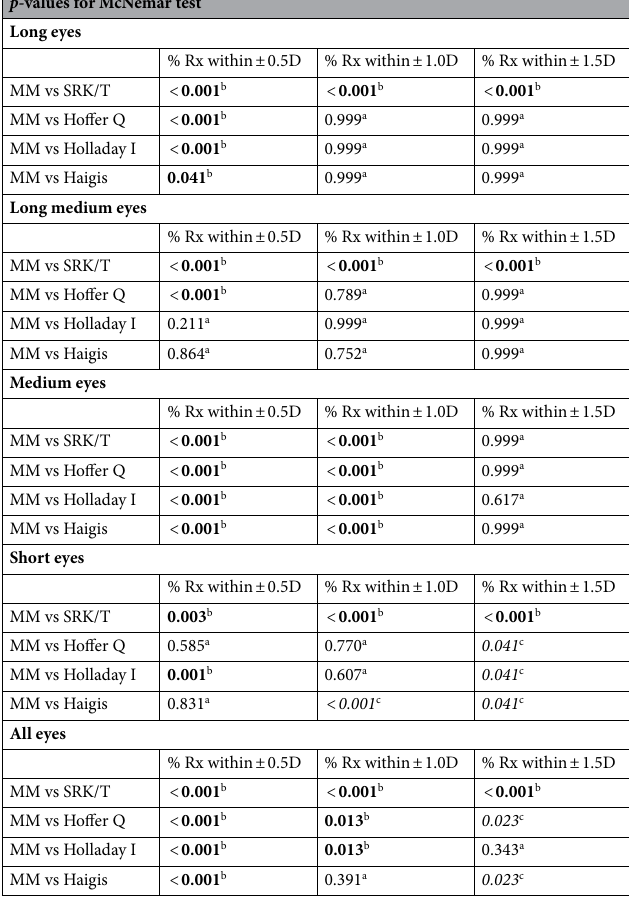
Table 7. Pairwise comparison of the prediction accuracy (i.e., the percentage of eyes within a given range of prediction error) between the MM formula and each of the other four formulae (SRK/T, Hoffer Q, Holladay I and Haigis) for the different types of eyes (long, long medium, medium, short and all eyes), using the McNemar test at a statistical significance level of 5%. a No statistically significant difference at level 0.05. b MM formula outperformed at significance level 0.05. c MM formula underperformed at significance level 0.05. Significant values are in [bold,